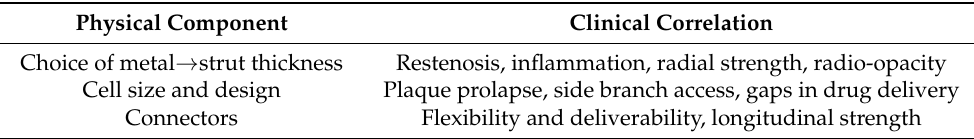
Table 1. Clinical impact of physical stent